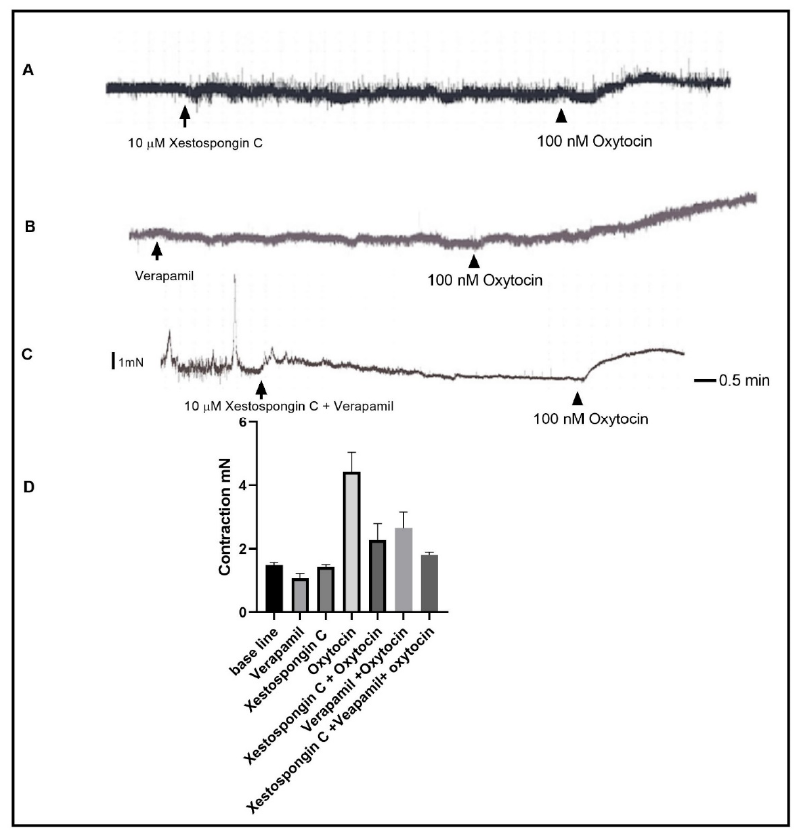
Figure 4. Effect of blocking IP 3 receptor and VGCC on oxytocin-induced contraction. ( A ) is a repre- sentative trace demonstrating 100 nM oxytocin self-induced contraction after 15 min of incubation with 10 µM of Xestospongin C. It also shows that Xestospongin C did not affect the baseline activity. ( B ) is a representative trace demonstrating 100 nM oxytocin-induced contraction after 15 min of incubation with 10 µM of verapamil. It also shows the verapamil effect on the baseline activity. ( C ) is a representative trace demonstrating 100 nM oxytocin-induced contraction after 15 min of incu- bation with both 10 µM of Xestospongin C and 10 µM of Verapamil. It also shows the effect on basal activity. ( D ) is a summary graph showing that oxytocin-induced contraction is significantly inhib- ited by Xestospongin C and by Verapamil and that the inhibition was greater when both agents were used. Data expression is in mN of force. Values are mean ± SEM. n = 7.